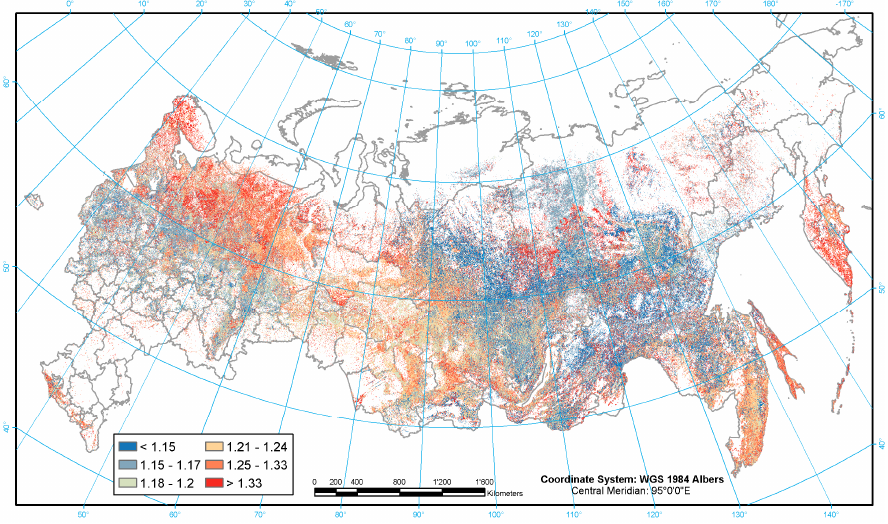
Figure 4. Geographic distribution of biomass expansion factors ( BEF ).